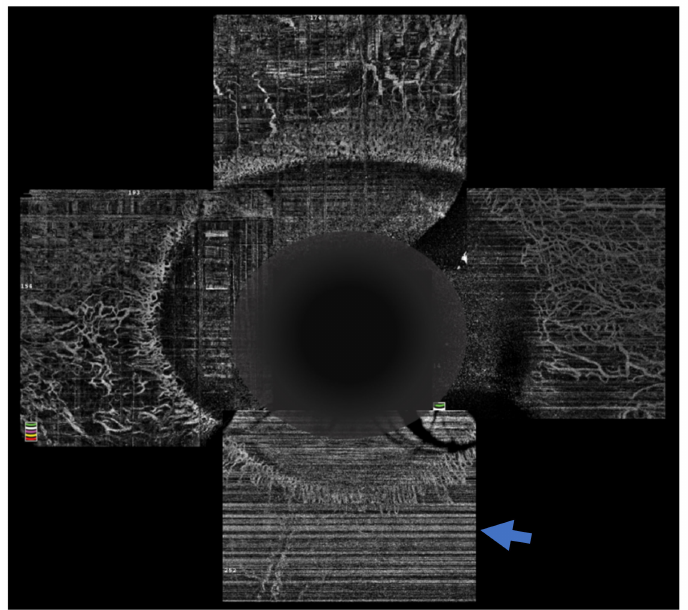
Figure 4. Optical coherence tomography angiography of an eye with chemical injury illustrating lack of vasculature inferiorly (arrow), in the area with